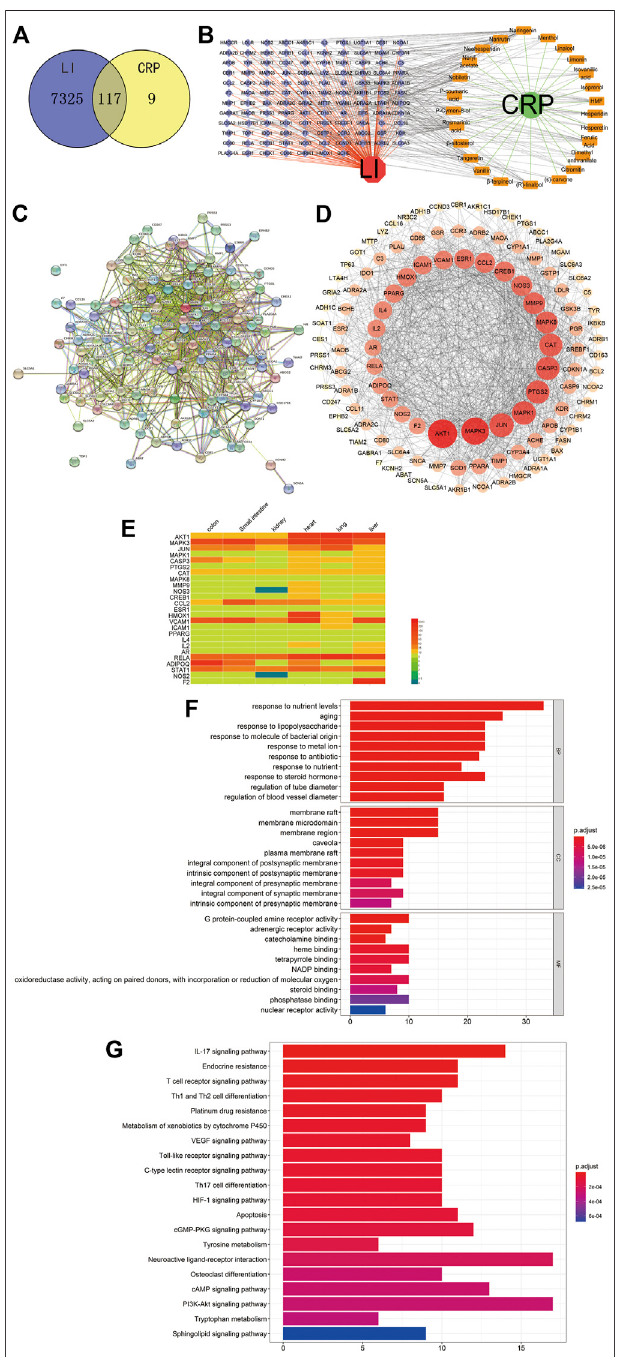
FIGURE 3 | (A) Venn diagram of related targets of CRP and LI. (B) D-C- G-D network. Green and red nodes indicate CRP and LI, respectively. Twenty- fi ve orange nodes represent active ingredients in CRP; 117 blue FIGURE3 |expressionofthecoretargetinvitalorgans.Redandblueindicate nodes represent overlapping gene symbols between diseases and higher and lower expression, respectively. (F) Bar graph of GO function drugs, with edges indicating that nodes can interact; red edges indicate the enrichment of overlapping targets. (G) Bar graph of KEGG enrichment of actionofLIwithgenes,greenedgesindicatetheinteractionofCRPwithactive overlappingtargets. The Y -axisrepresentsGOtermsorKEGG pathways. The ingredients, and gray edges indicate the interaction of active ingredients with X -axis indicates the number ofgenesenriched inthis pathway. The redder the genes. (C) The PPI network was obtained from the STRING database color, the smaller the p. adjust value; it also indicates the reliability and platform. (D) The PPI network is arranged according to degree value. (E) The importance. The bluer the color, the greater the p. adjust ( Continued )